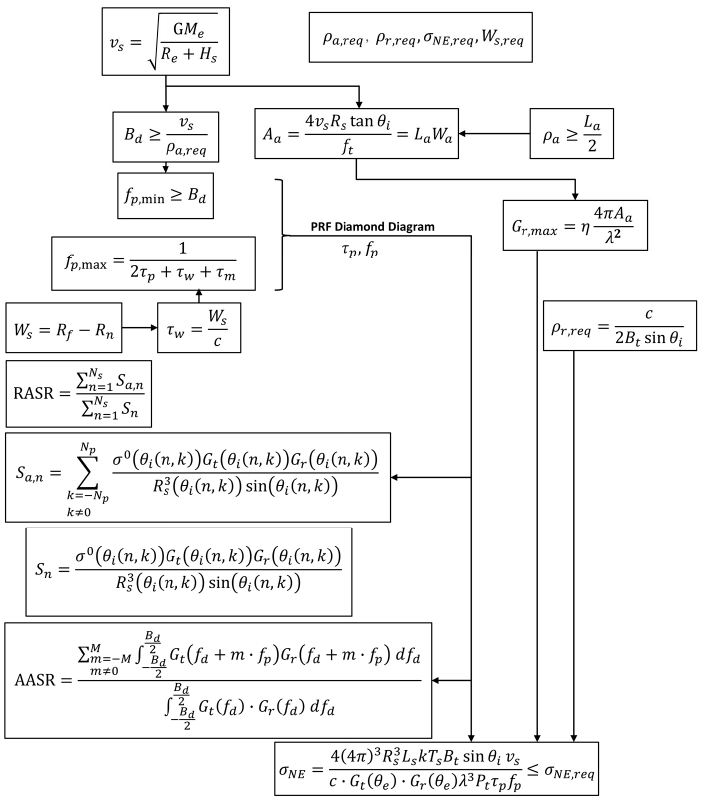
Figure 5. Design workflow of the SAR payload of S-STEP according to the required resolution, swath width, and NESZ sensitivity where ρ r , req required range resolution, ρ a , req required azimuth resolution, σ NE , req required NESZ, W s , req required swath width in range, B d Doppler bandwidth, A a antenna area, L a antenna length, W a antenna width, f t transmitted frequency, η antenna efficiency, f p , min minimum PRF, f p , max maximum PRF, R n near range of swath, R f far range of swath, W s swath width in range, τ w time duration of swath, τ m guard time, G universal gravitational constant, M e mass of the Earth, R e radius of the Earth, and H s satellite altitude,